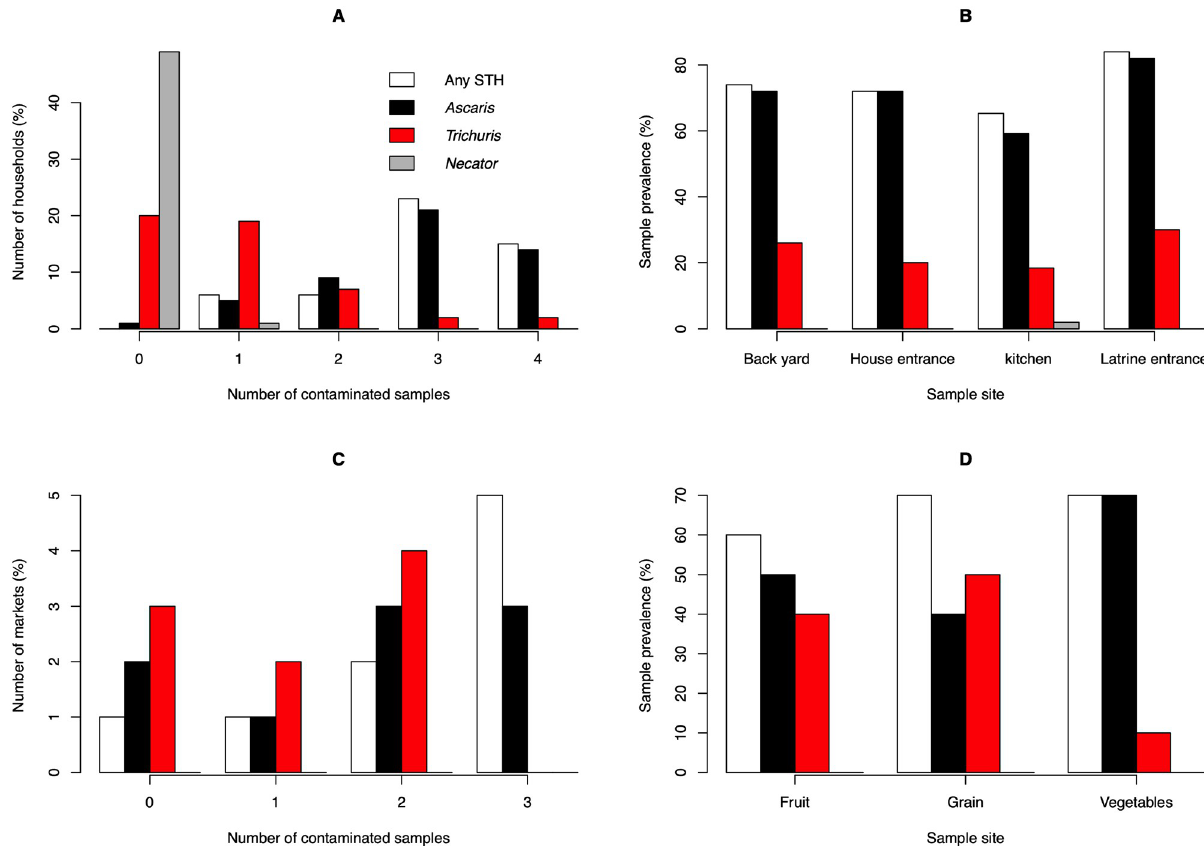
Fig 5. The environmental contamination with human STHs at the households and open markets. This figure illustrates the environmental soil- transmitted helminth contamination across 50 households (Panels A and B) and 9 open markets (Panels C and D).